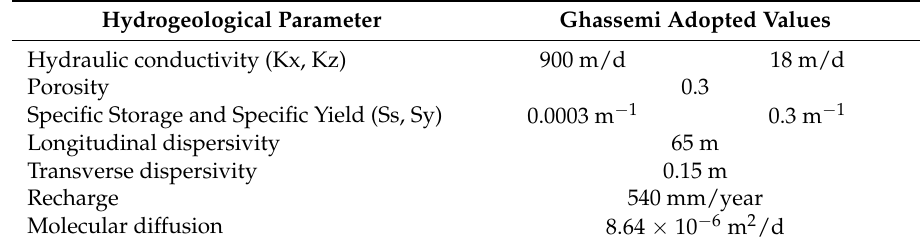
Table 2. Hydrogeological parameters initially assigned to the 2D models (from Ghassemi et al., [29]). Hydrogeological Parameter